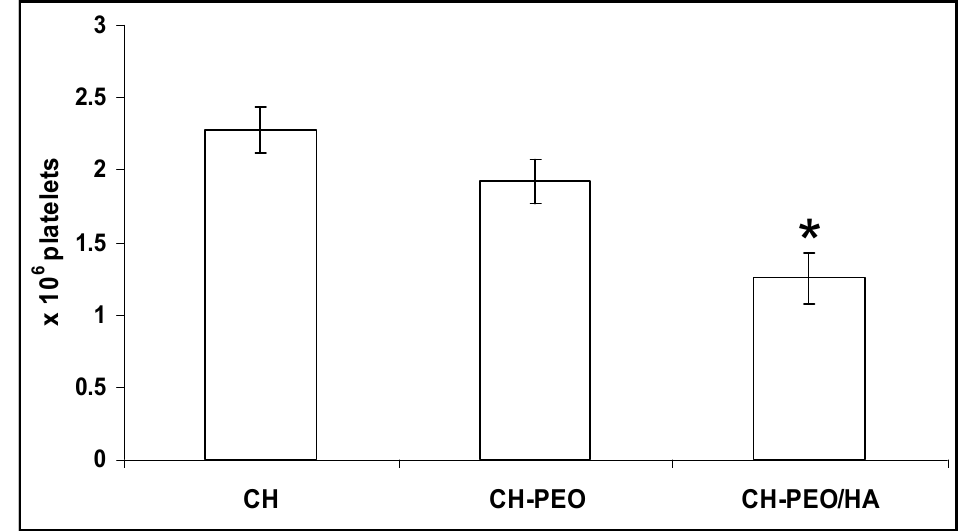
Figure 11. Platelet adhesion on different surfaces: Chitosan (CH), chitosan-PEO blend (CH-PEO), and chitosan-PEO blend coated with a monolayer of hyaluronan (CH- PEO/HA). Pure CH was used as control; * indicates statistical significance with p<0.002,